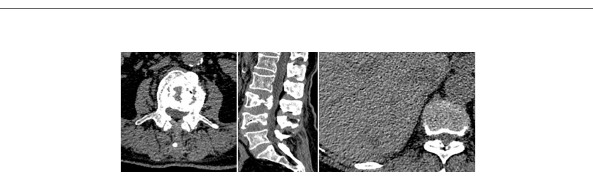
FIGURE 2 | Primary spinal epithelioid hemangioendothelioma (EHE) in a 74- year-old woman. A sagittal image of the lumbar spine reveals a mass that has soap bubble bone destruction in the vertebral body with a secondary vertebral compression fracture. Liver metastasis was demonstrated with an irregular outer layer (arrow).